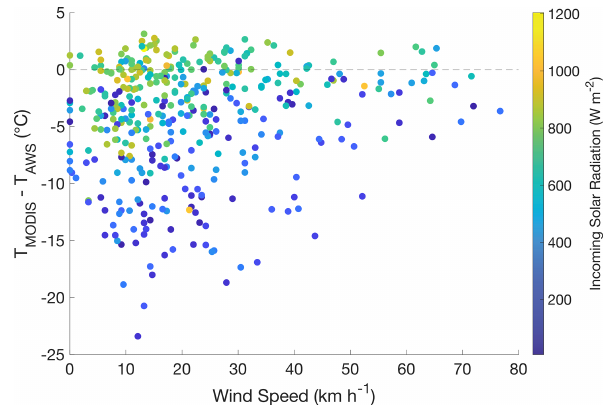
Figure 8. Comparison of the MODIS LST offset (MODIS − AWS) with measured solar radiation and wind speed at Divide. The MODIS LSTs show the most pronounced cold offset at low lev- els of solar radiation (shown by marker color) and low wind speeds. Horizontal dashed line marks all locations where MODIS =